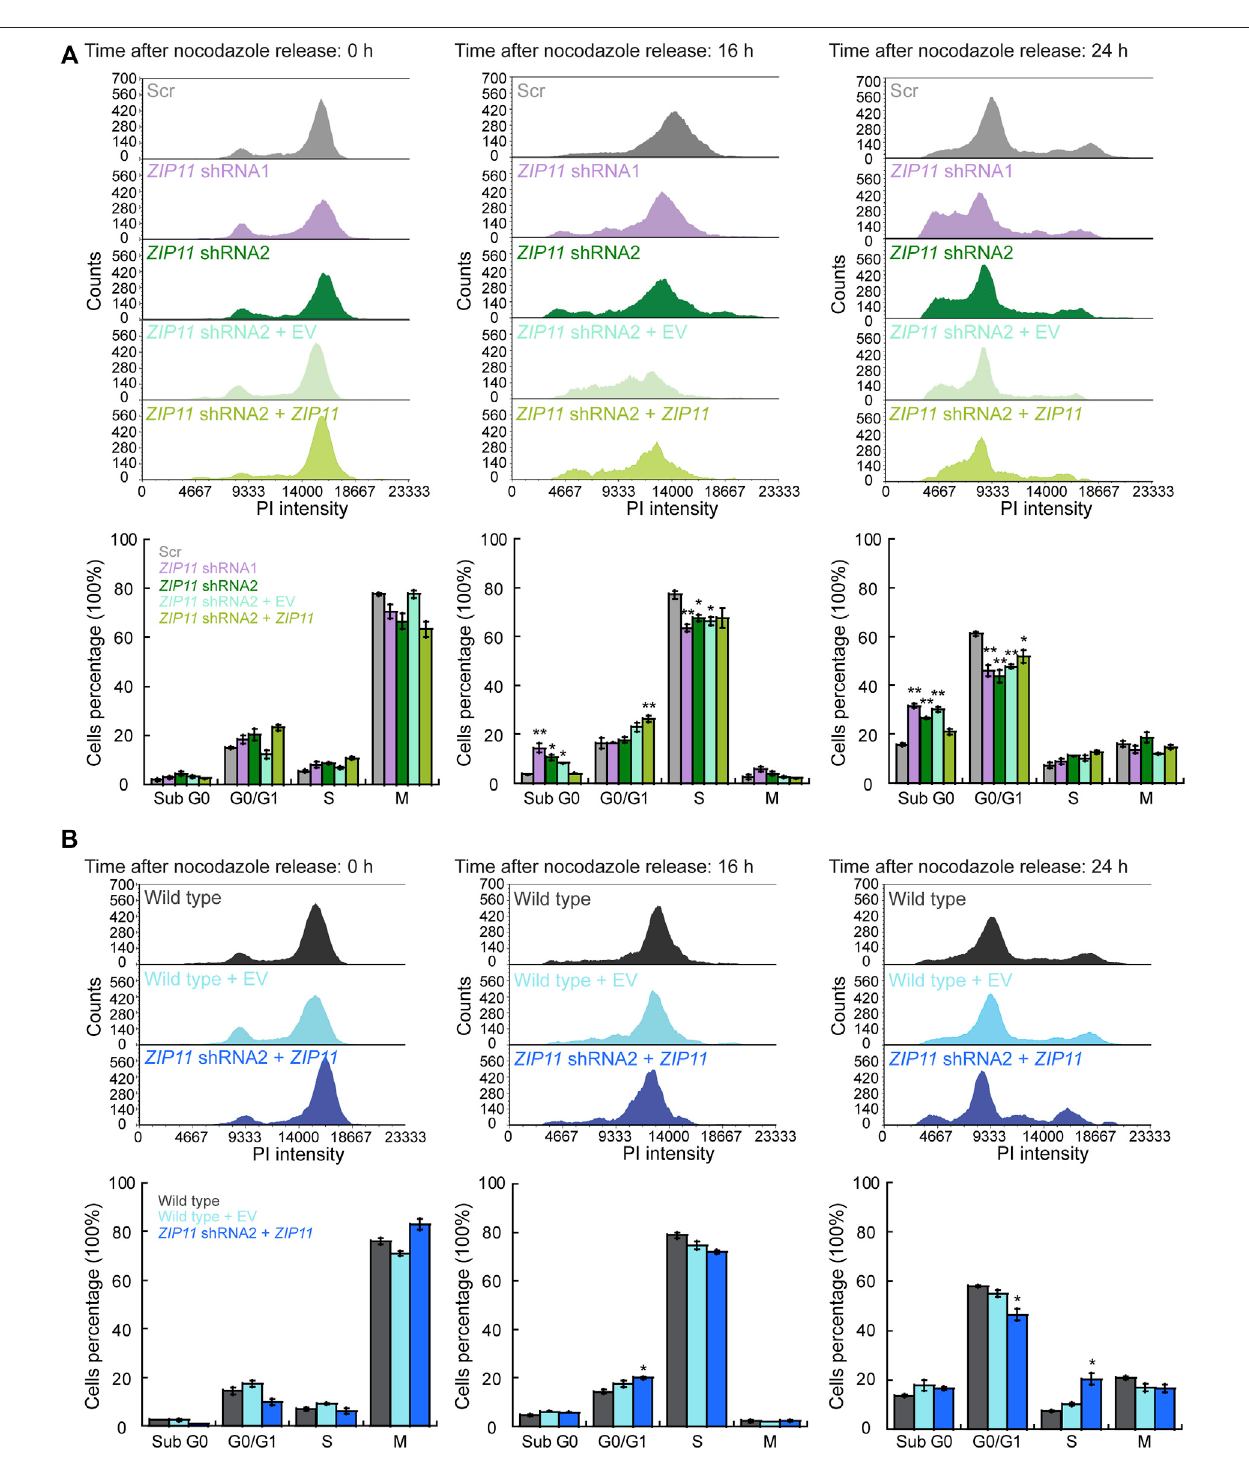
FIGURE9| Knockdown ofZIP11alters cellcycle progression.Representativehistograms ofcellcycle progression(top panels) andpercentage ofcellsineach cell cycle phase (bottom panel). (A) HeLa cells transduced with Scr, ZIP11 shRNA1 or shRNA2 and reconstituted with an empty vector or ZIP11 gene. (B) Wild type HeLa cells transduced with an empty vector or overexpressing ZIP11. Plots show cells arrested in mitosis with nocodazole at the time of release (0 h), and after 16 and 24 h post-release. The data are representative of three independent biological experiments. * p < 0.05; ** p < 0.01.